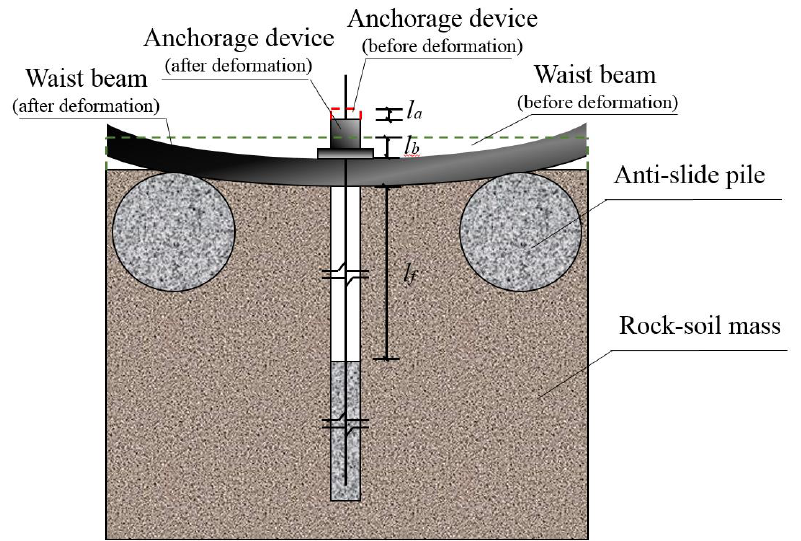
Figure 1. Schematic diagram of the deformations of anchorage device and waist